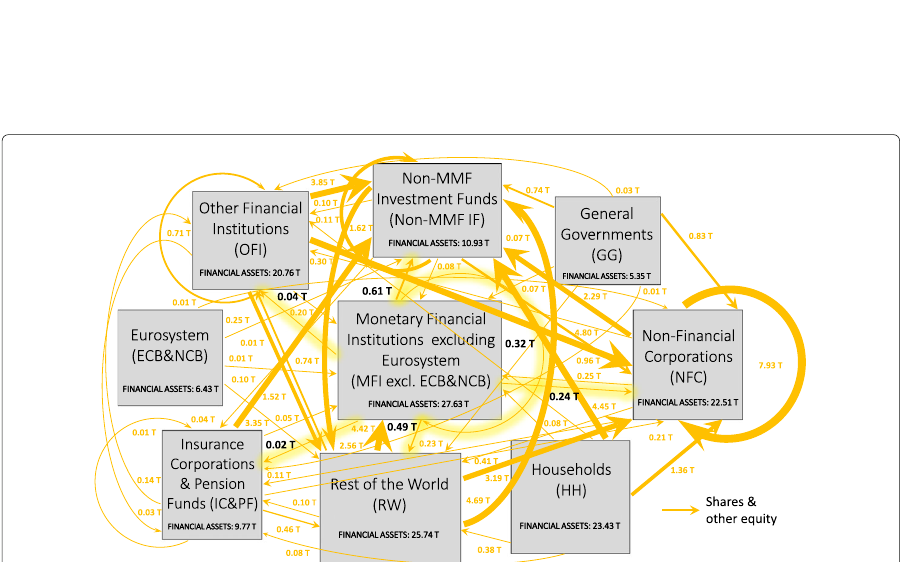
Fig. 8 The euro area macro-network of financial exposures via shares and other equity; June 2017. The macro-network of financial exposures among the different institutional sectors operating in the euro area (i.e., Eurosystem (ECB&NCB), Monetary Financial Institutions excluding the Eurosystem (MFI excl. ECB&NCB), Other Financial Institutions (OFI), Non-MMF Investment Funds (Non-MMF IF), Insurance Corporations and Pension Funds (IC&PF), Households (HH), Non-Financial Corporations (NFC), and General Governments (GG)), and Rest of the World (RW), via listed, unlisted, and investment fund shares and other equity (represented with yellow links), with reference to the second quarter of 2017. Weights represent the outstanding financial exposures of a source institutional sector to a target institutional sector expressed in trillion euros. Data source: (European Central Bank